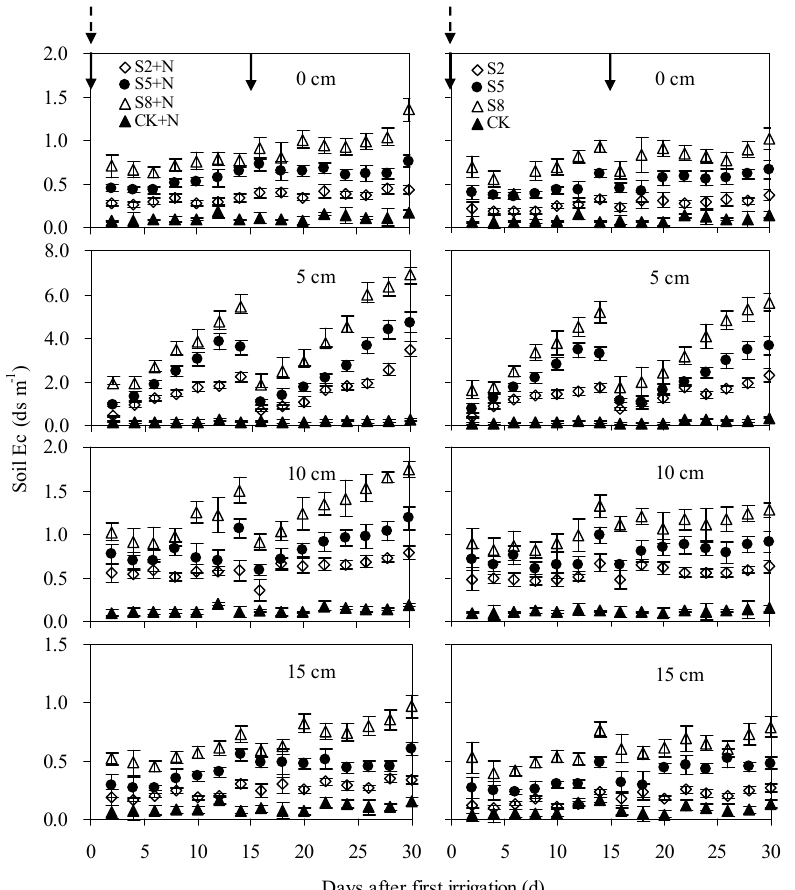
Figure 4. Soil Ec at 0, 5, 10 and 15 cm depths after two irrigation events from 2 July to 18 August. Solid arrow and dotted arrow represent irrigation and fertilization event, respectively. S2, S5 and S8 represent soils irrigated with water at 2, 5 and 8 g/L salinity level; S2 + N, S5 + N and S8 + N represent soils irrigated with water at 2, 5 and 8 g/L salinity level and nitrogen fertilization (120 kg N/ha) application. CK + N and CK represent soils irrigated with fresh water at N120 and N0 level, respectively.